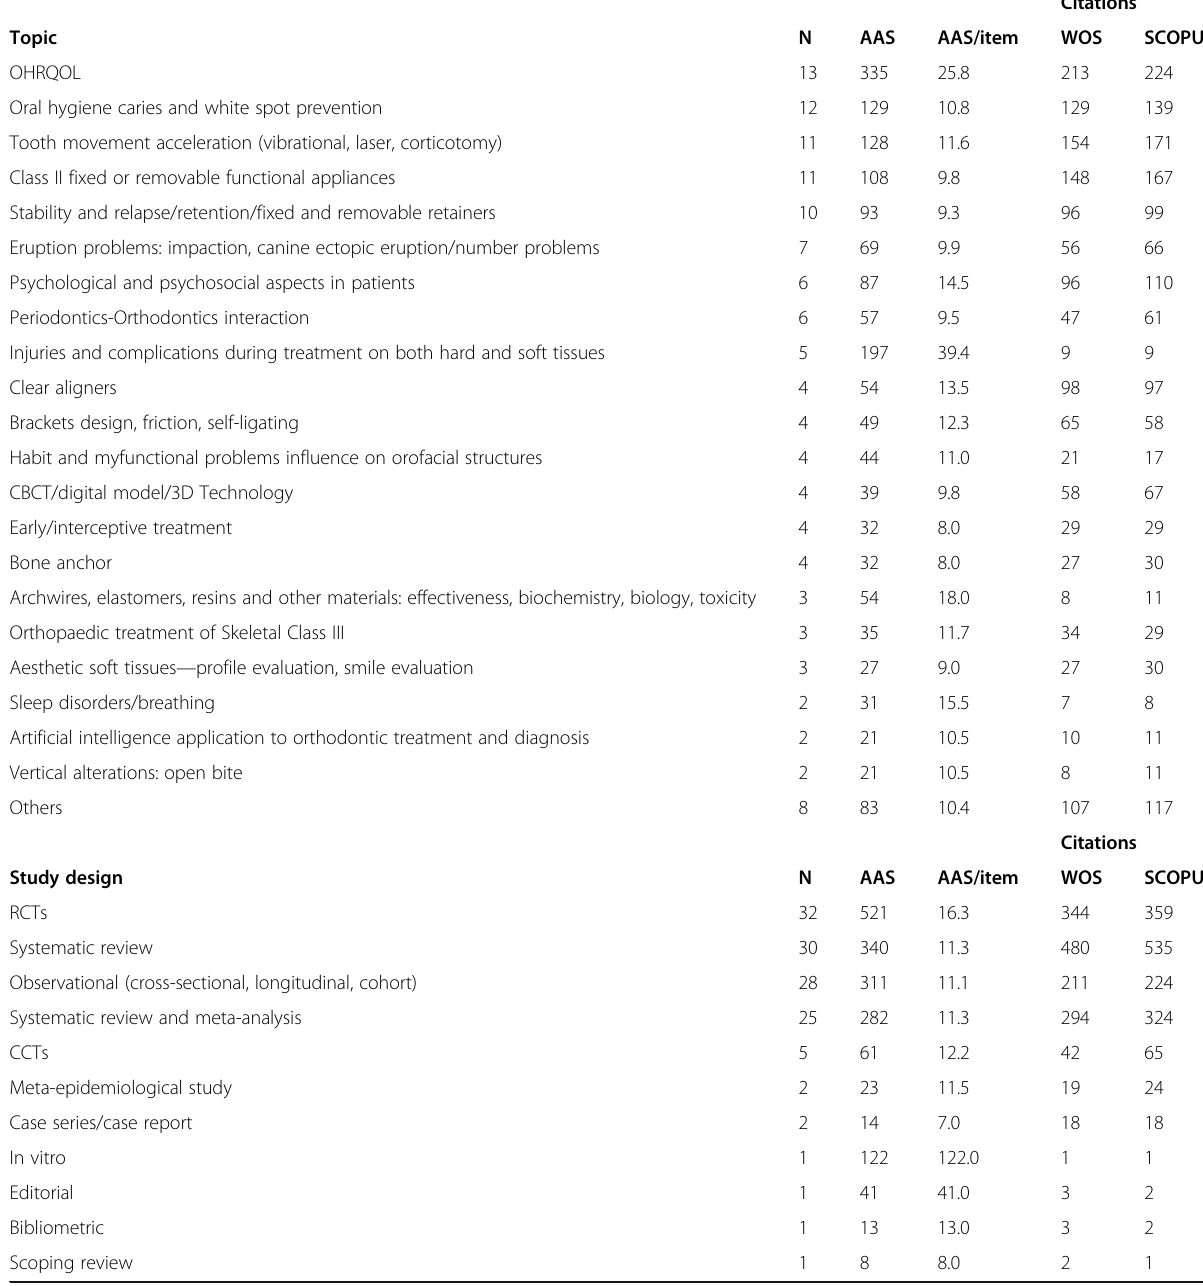
Table 3 Summary statistics for article topic and study design, number ( N ) of articles per topic and study design, Altmetric Attention Score (total), AAS per item and citation count in Web of Science (total), and Scopus (total) are